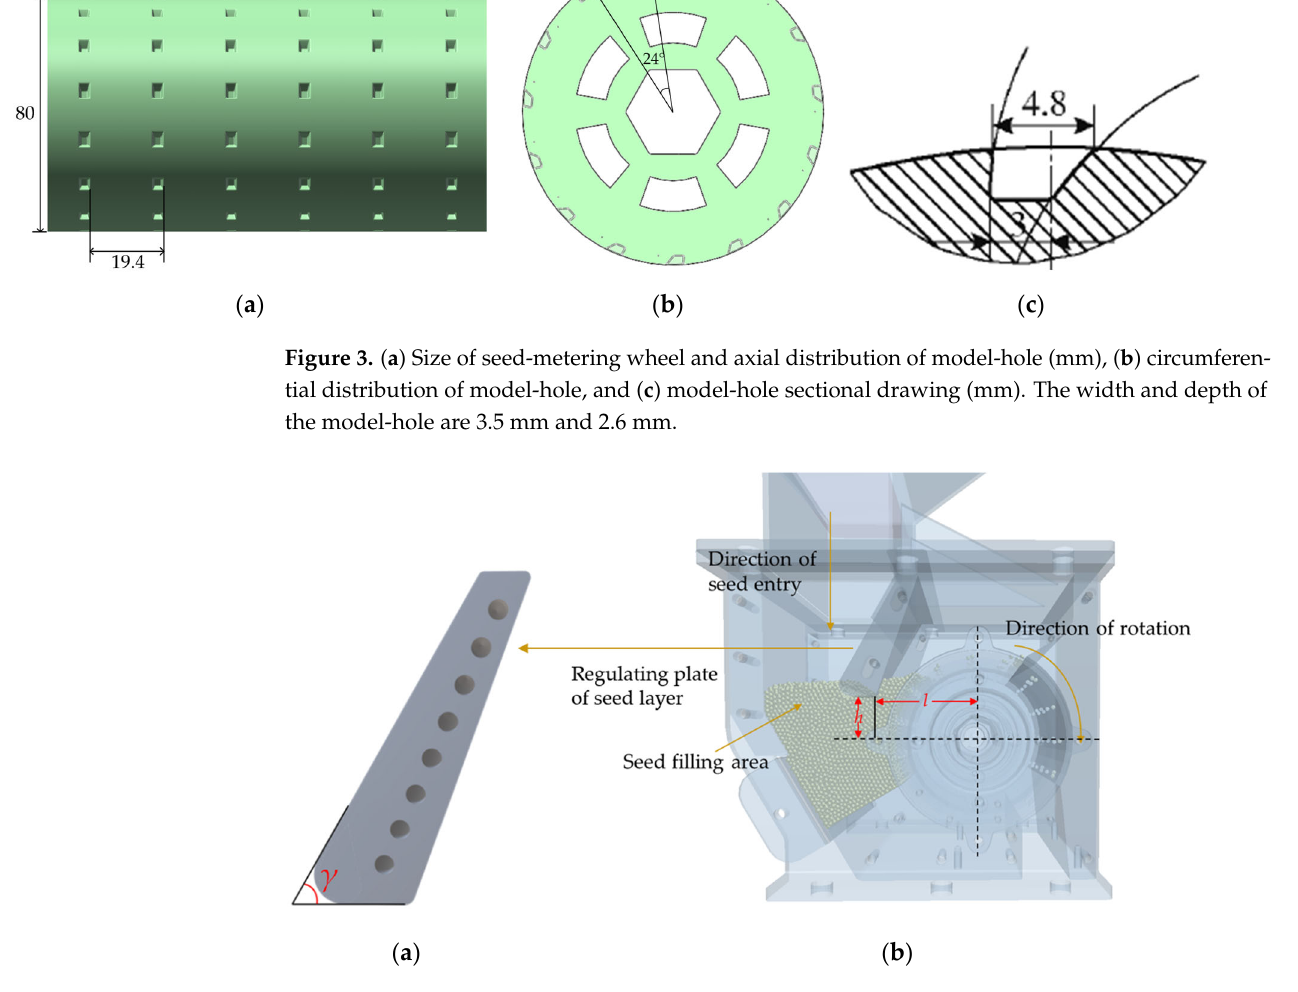
Figure 4. ( a ) Inclination angle of the regulating plate of seed layer ( γ = 60°), and ( b ) sketch map of longitudinal distance ( h ) and lateral distance ( l ).